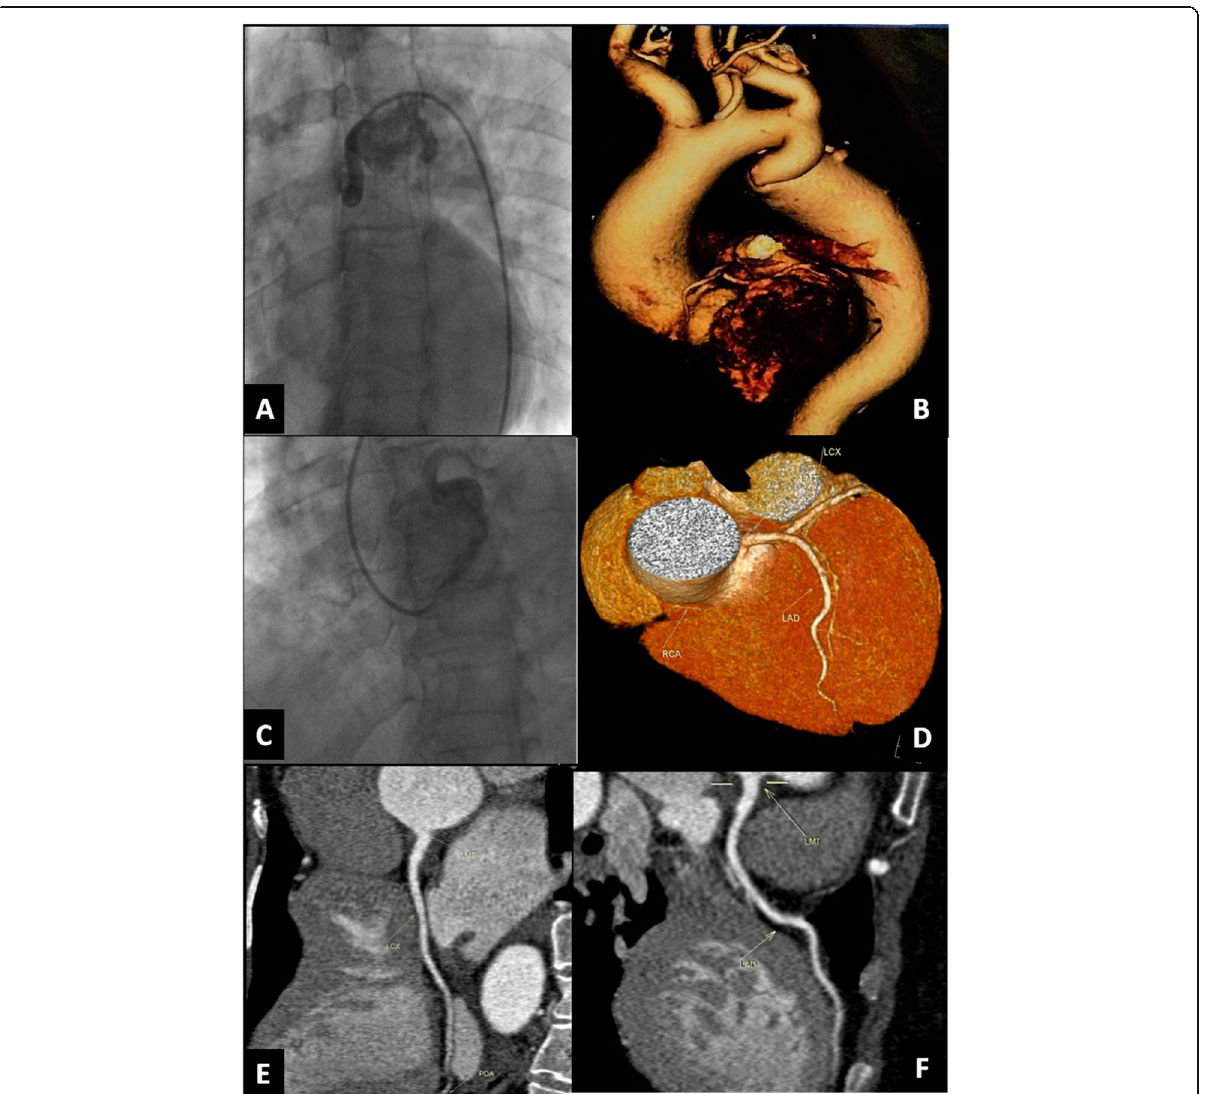
Fig. 3 Demonstration of a case of aortic coarctation with the inability to pass the catheter. A Difficult passage of catheter due to aortic coarctation. B VRT of CT aortography reveals aortic coarctation just distal to the origin of the left subclavian artery. C Non-selective injection of contrast by catheter due to the difficult engagement of coronaries. D VRT of CCTA reveals the anatomy of different coronary arteries. E , F MPR of CCTA reveals normal LCX and LAD,